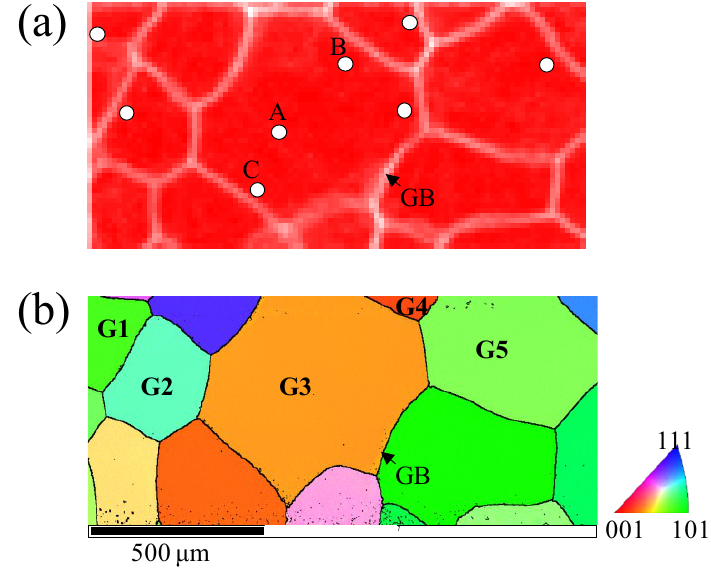
Figure 3. Images showing the microstructure of Cu-Al-Mn alloy. The measurement area shown in Figure 2 was imaged by ( a ) white X-ray microbeam diffraction and ( b ) electron backscattered diffraction (EBSD). White dots in ( a ) denote strain/stress measurement points. GB indicates grain boundary.